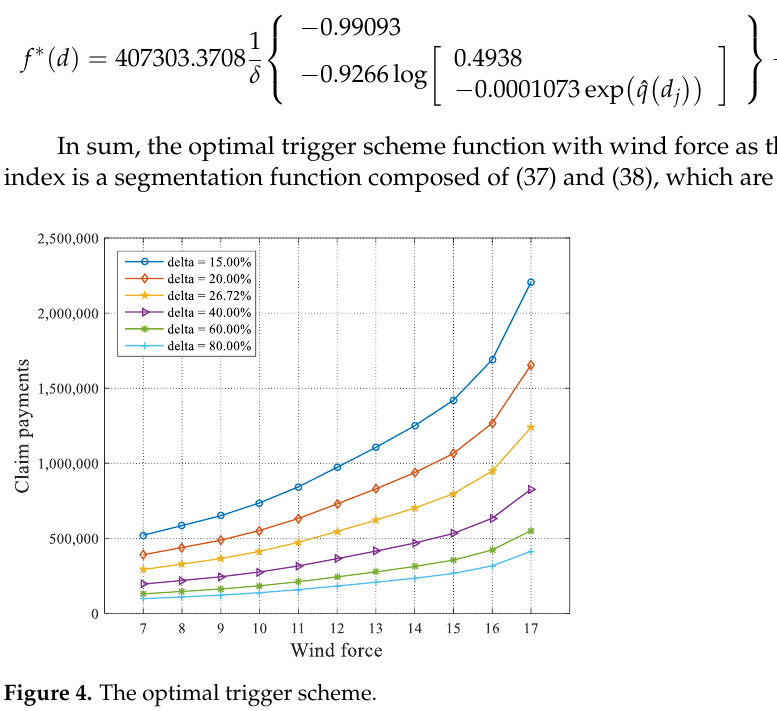
Figure 4. The optimal trigger scheme.